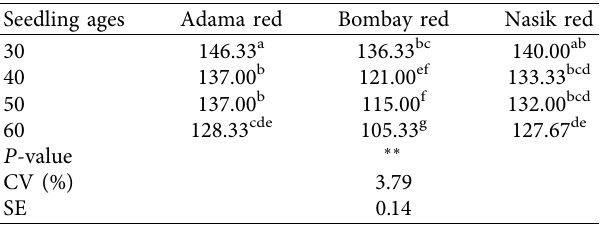
Table 2: Interaction efect of seedling age and variety on days to maturity of onion. Seedling ages